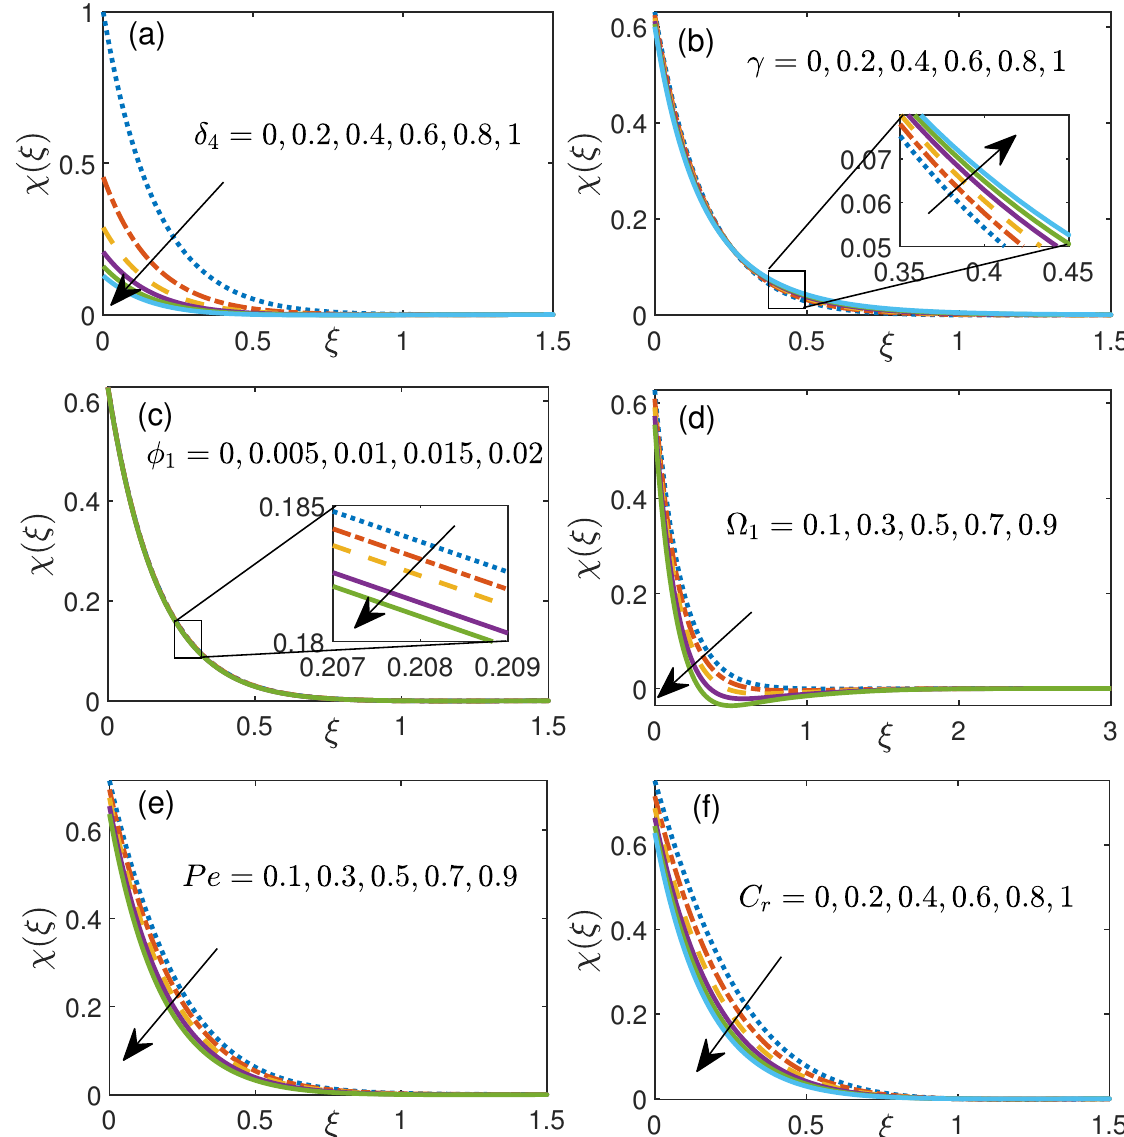
Figure 6. Motile density micro-organism distribution for ( a ) motile slip parameter δ 4 , ( b ) curvature parameter γ , ( c ) initial volume fraction φ 1 , ( d ) concentration difference parameter Ω 1 , ( e ) Peclet number Pe , ( f ) chemical reaction C r